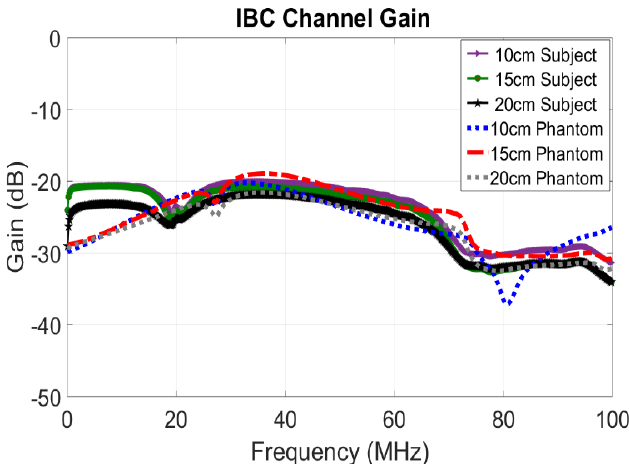
Figure 3. Intra-Body Communication (IBC) channel gain, for a human subject vs for a phantom, when varying the distance between the transmitter and the receiver to be at 10, 15, and 20 cm and separation between electrodes of each node is 5 cm.